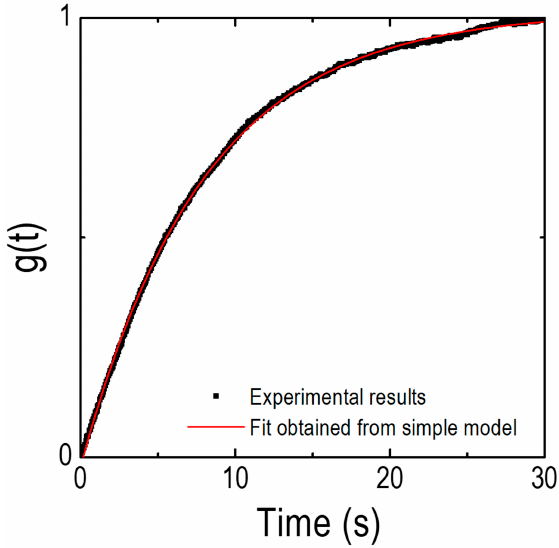
Figure 2. Experimental and fitted ECR data obtained from the ~3 nm LNO-decorated LSCO film 1 under a gas switch from 0.5 to 0.1 atm at 450 ◦